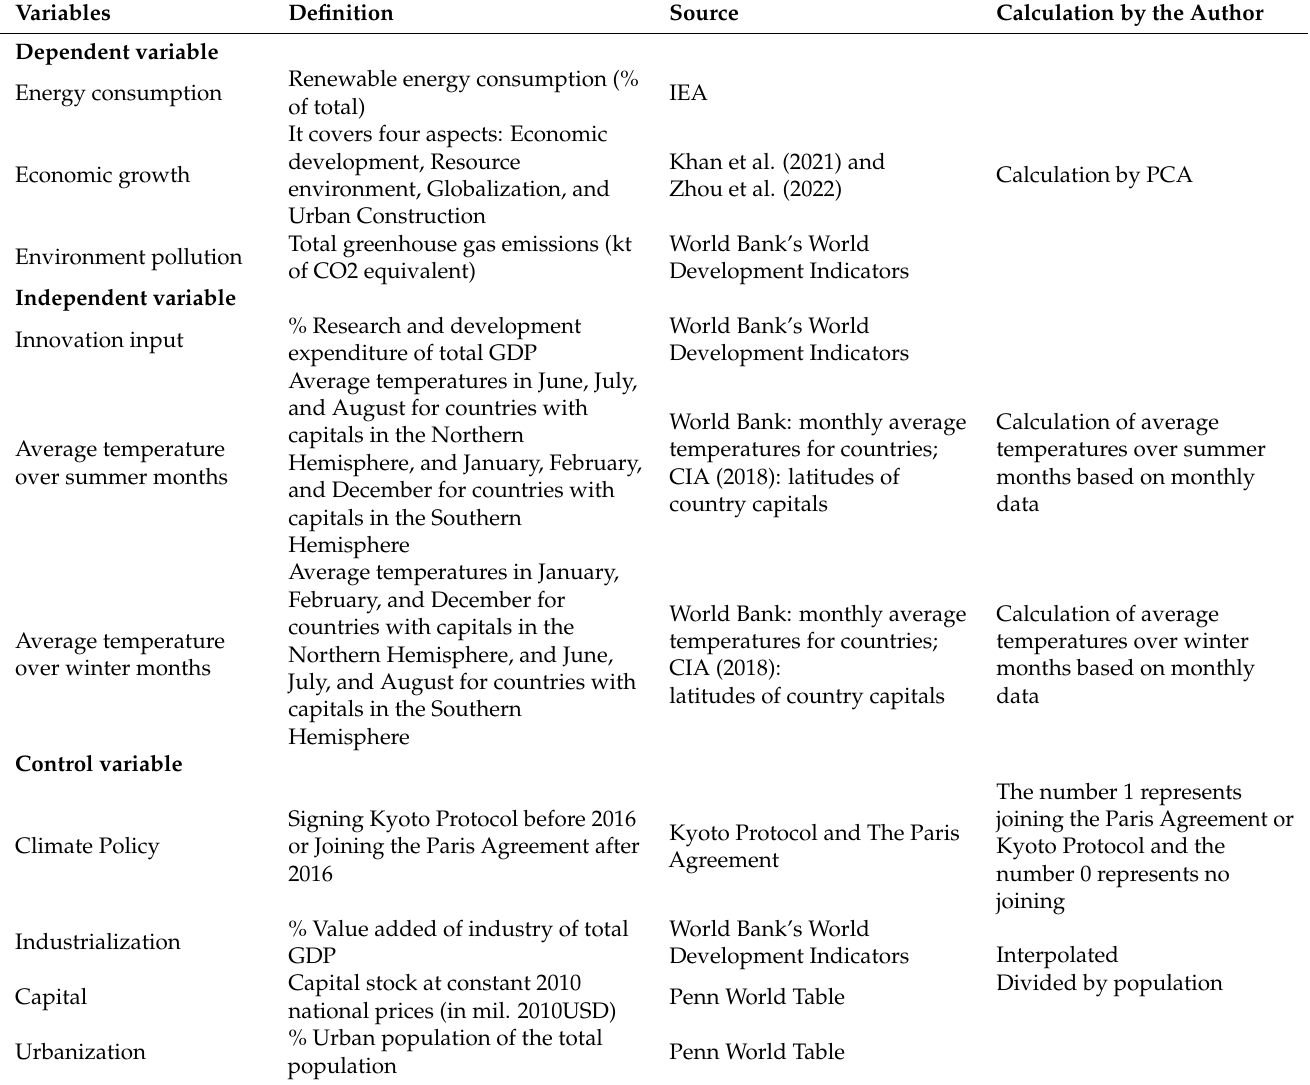
Table 2. The definition and source of